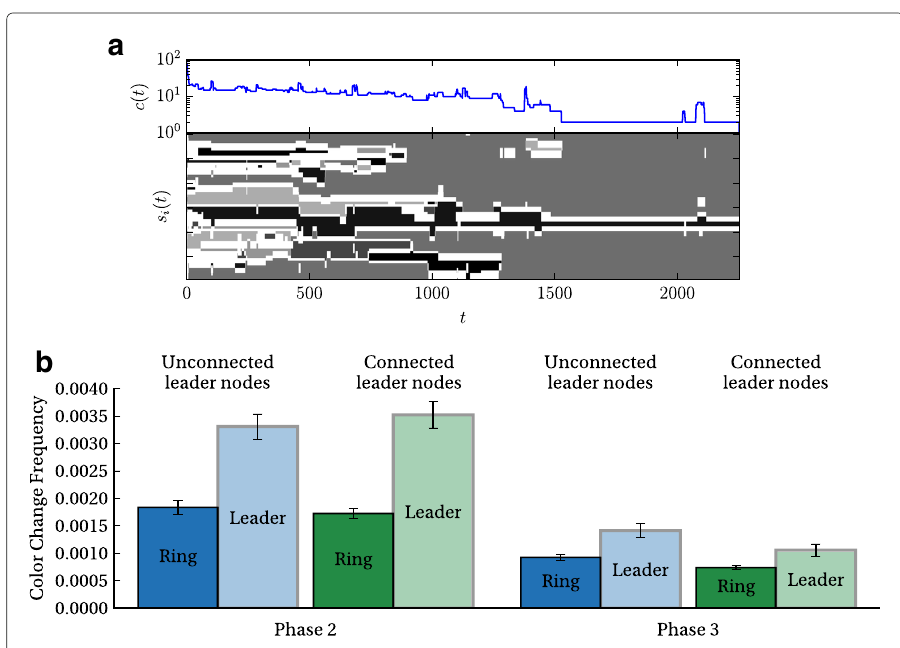
Fig. 3 Individual and collective node activity over time. a Exemplary domain evolution along the ring-nodes, together with the evolution of conflicts c ( t ) in the graph (log-scale). Parameter settings are: N = 60, χ = 4, s = 30, k L = 20 with no connection between leader nodes. b Color change frequencies over the last two phases of the solution process. Error bars show standard error of sample